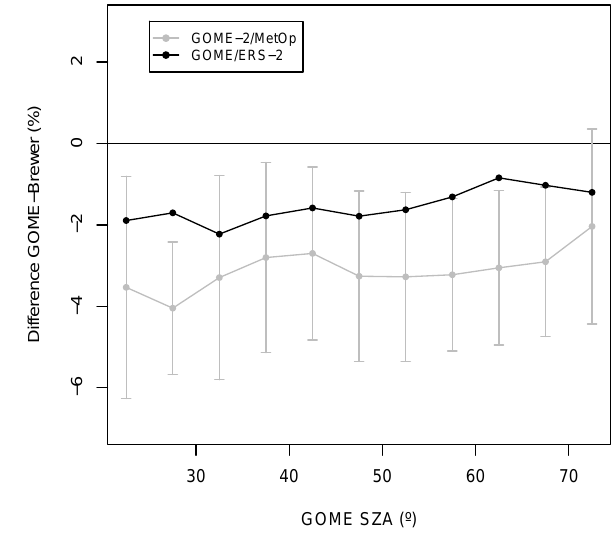
Fig. 1. Seasonal variation of the daily relative differences be- tween Brewer daily total ozone values and GOME-2/MetOp data (grey line), and running mean over ten days (dark grey line) for the “Iberian Peninsula” dataset. The black line denotes the run- ning mean over ten days for the relative differences obtained with GOME/ERS-2 data.